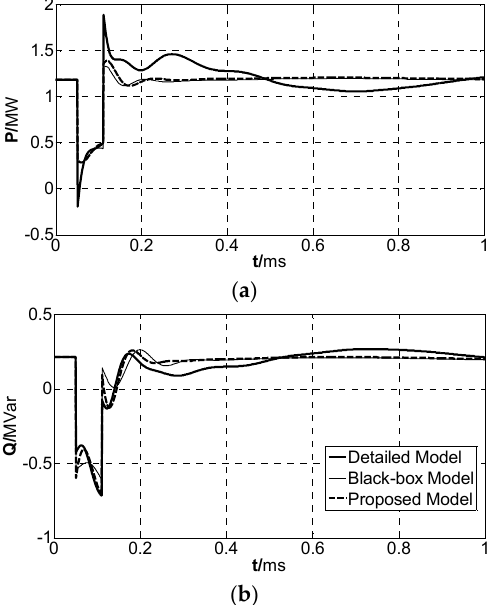
Figure 10. ( a ) Dynamics of Active Power of different models; ( b ) Dynamics of Reactive Power of different models.